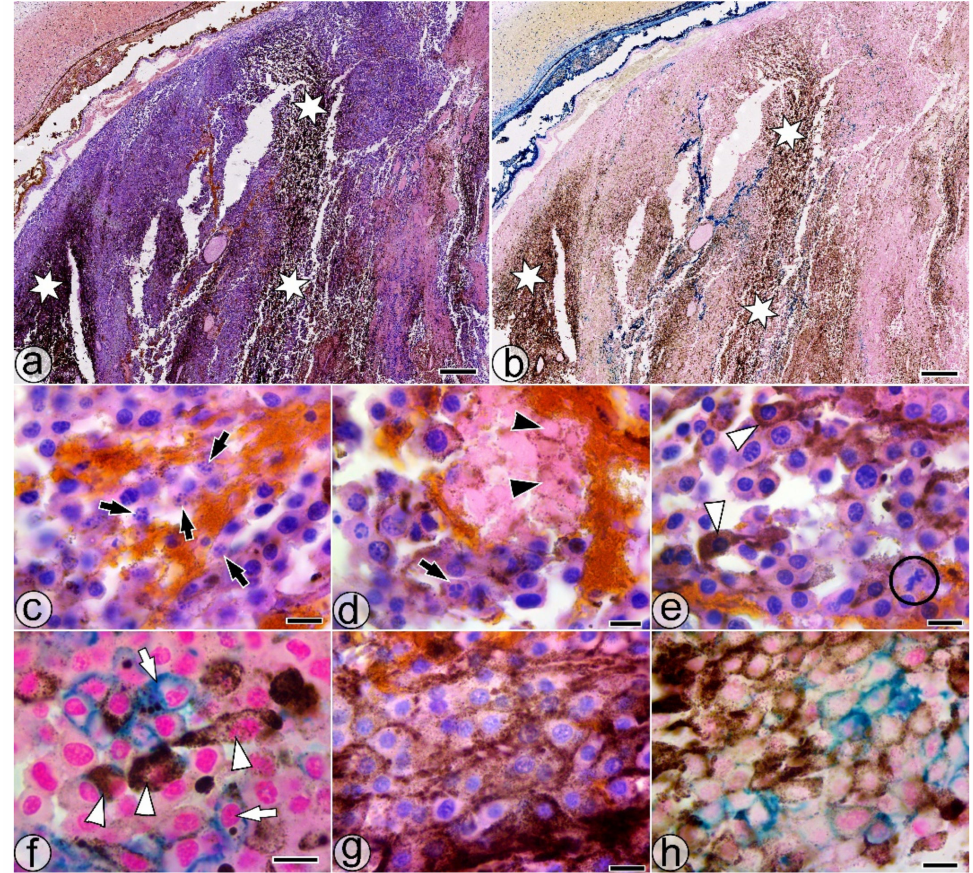
Figure 4. Histological features of the SaIONs-injected area in the ITO1w group. ( a , b ) Overall ap- pearance of the hyperpigmentation in the injected area (white stars). ( c , d ) Weakly pigmented melanoma cells with fragmented nuclei (black arrows) and ghost cells without nuclei (black arrowheads). ( e ) Area with SaIONs deposits and PMCs with varying degrees of melanin loading (white arrowheads), some in division (black circle). ( f ) Cluster with HPMCs (white arrowheads) and SaIONs-loaded melanoma cells (white arrows). ( g , h ) Deposits of pigment and SaIONs in the jux- tamembranous regions of the melanoma cells. HE ( a , c , d , e , g ) and Perl Prussian blue ( b , f , h ) staining. Bar = 10 µ m ( c – h ), 1 mm ( a , b